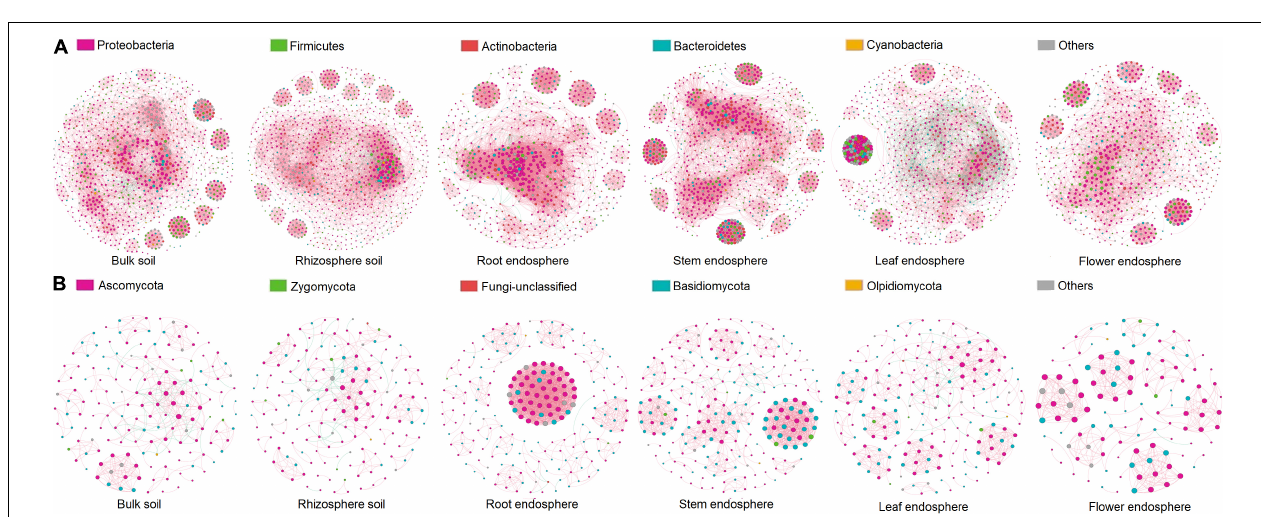
Table 3 ). Higher values of topological properties (i.e., nodes, edges, positive edges, average clustering coefficient, and total triangles) were detected in the root endosphere (993, 13,480, 13,431, 0.74, and 128,440, respectively) than those in